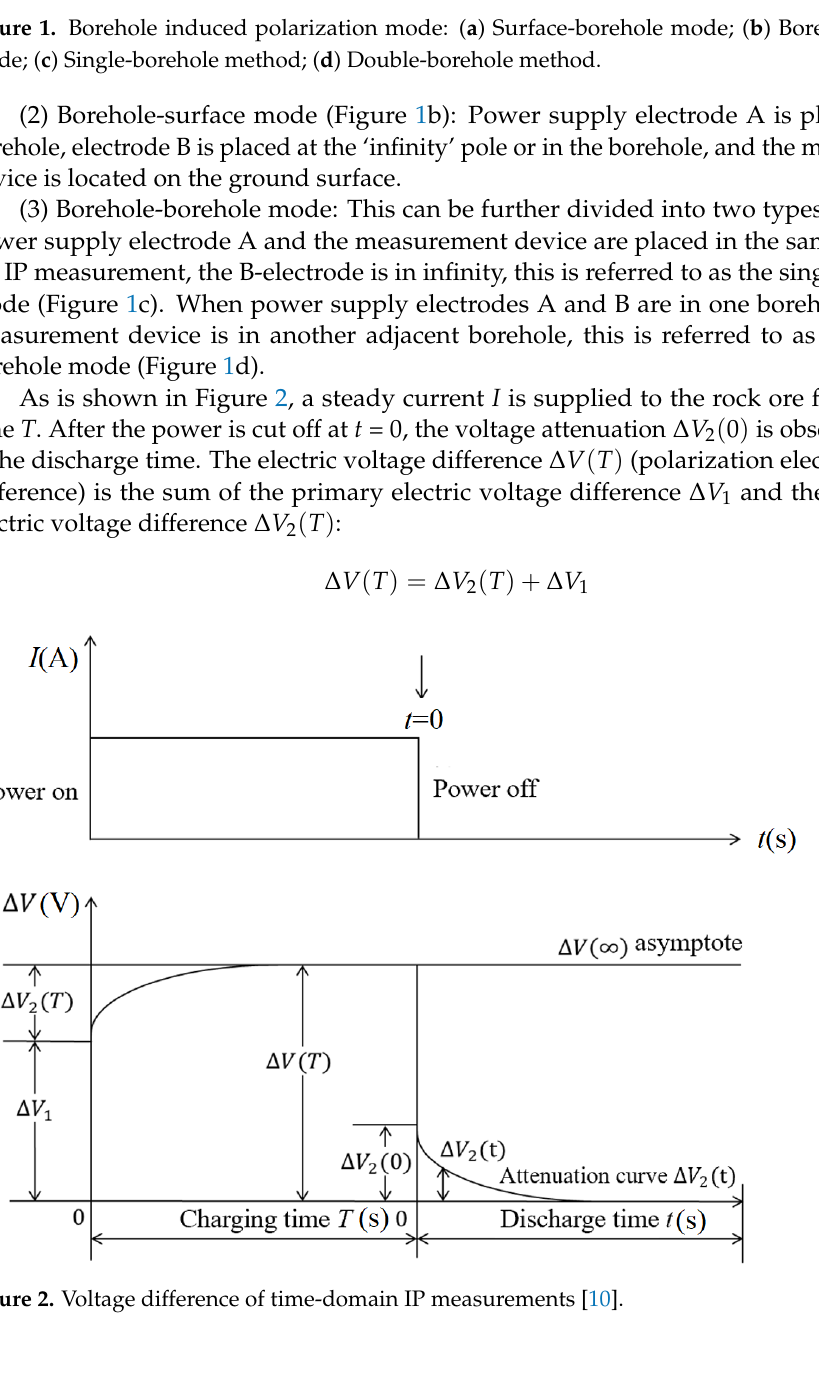
Figure 2. Voltage difference of time-domain IP measurements [10].